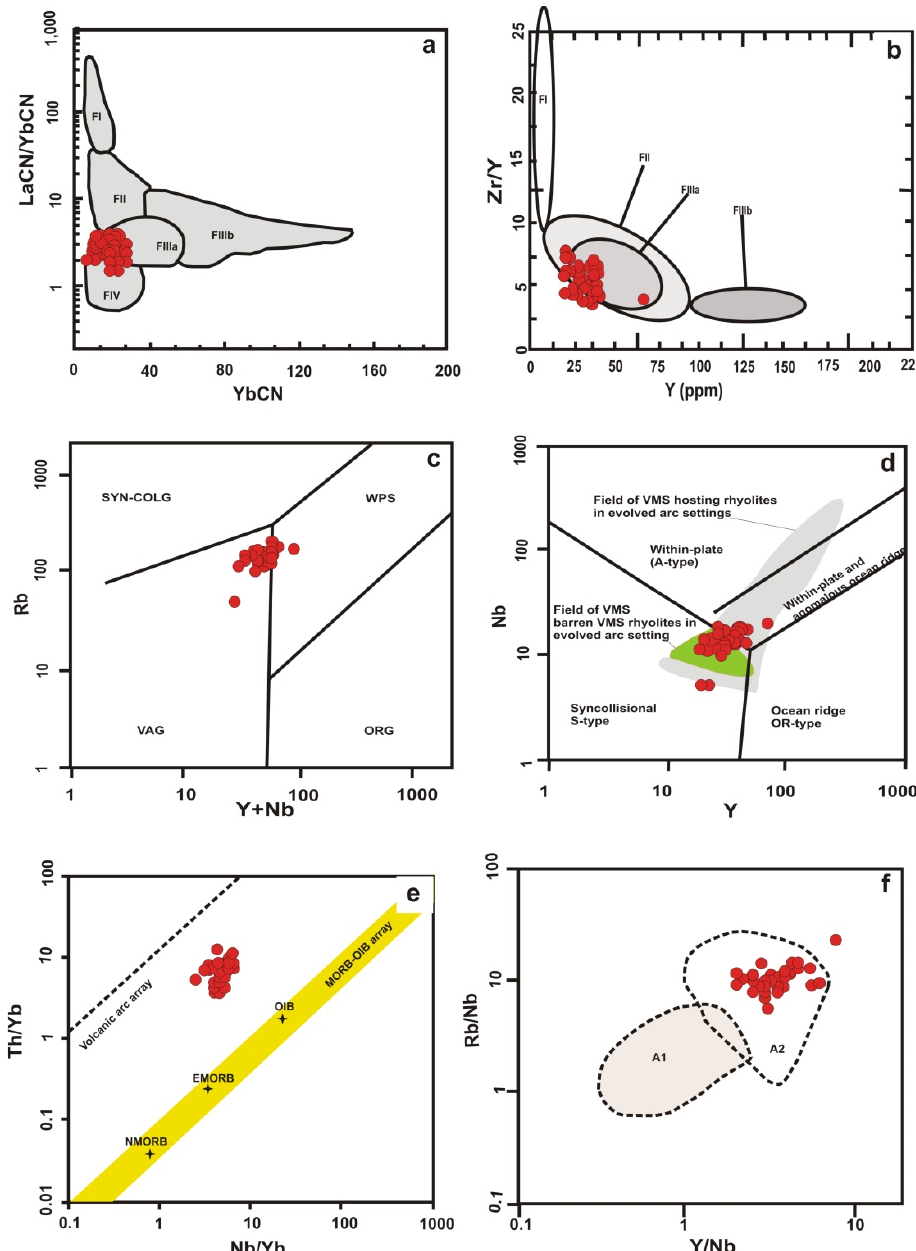
Figure 12. Petrochemical affinity of the felsic volcanic rocks ( a ) Chondrite nornamilized [81] La cn /Yb cn vs Yb cn rhyolite discrimination diagram after [75,76]; most of the felsic rocks show FIIIa affinity and a few show FII and FIV affinities; ( b ) Zr/Y vs. Y diagram of [75], as modified by [55], with magmatic affinities based on Zr/Y ratios from the concepts of [82]; most of the felsic rocks have FIIIa to FII affinity; ( c ) Rb vs. Y + Nb tectonic discrimination diagrams of [78] for granitoid rocks and samples show VAG (Volcanic Arc Granite) and WPG (Within Plate Granite) ( d ) Zr vs. Nb plot shows that the felsic volcanic rocks are HFSE-enriched and support the evolved arc setting after [83]: the fields of VMS-barren (green shaded color) and VMS-hosting rhyolites (grey shaded color) in post-Archean continental crust-associated setting. The shaded fields are from [83]. The sample falls on the syncollisional S-type granite and within plate granite. ( e ) Th/Yb vs Nb/Yb plot is from [79]. The sample falls on volcanic arc array field ( f ) Rb/Nb vs Y/Nb diagram, A1, mantle derived and A2, crustal-derived granitoid rocks [80]; felsic volcanic samples fall in A2, which shows crustal derivative signature. (Data source: Table S1).